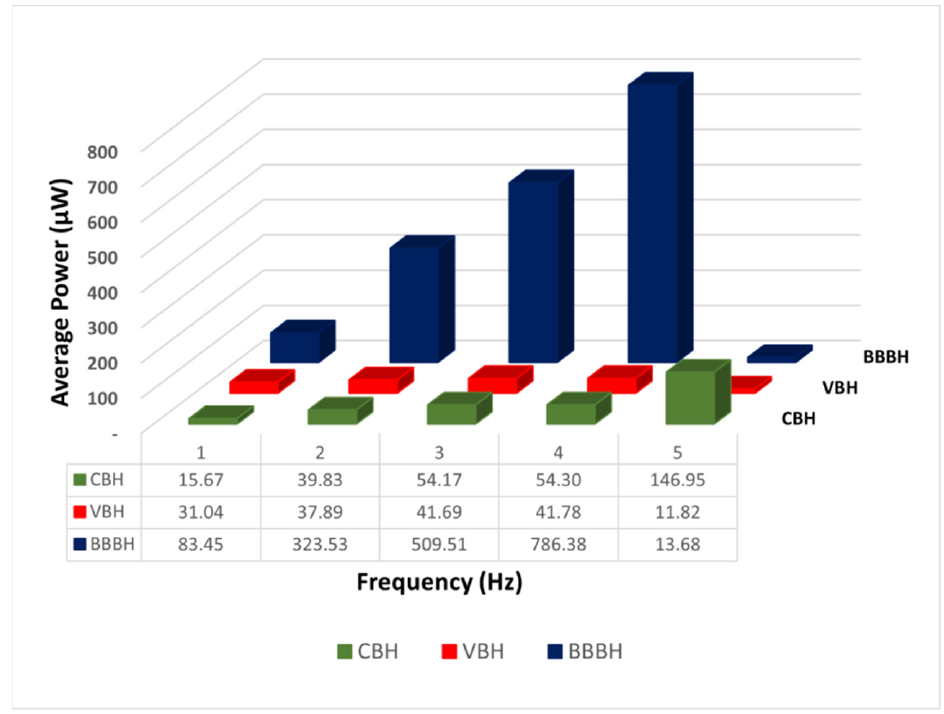
Figure 11. Comparison of average output power against frequency generated by three PEH designs under 1 g acceleration.